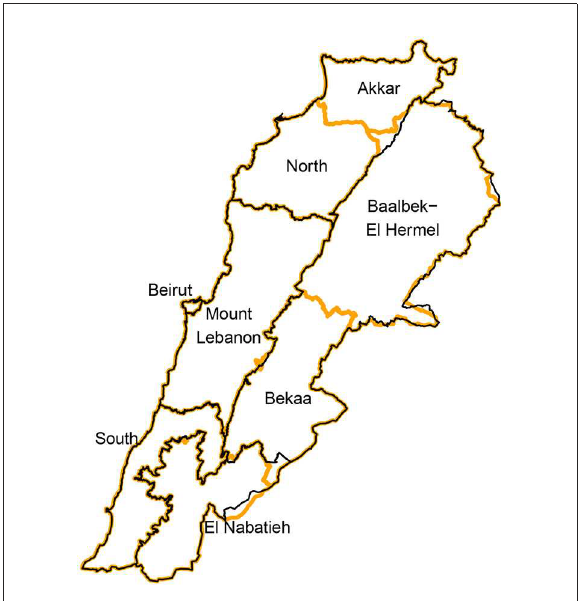
FIGURE1 Governorates of Lebanon (orange) overlaid with Facebook regions (black) that can be targeted for advertising.